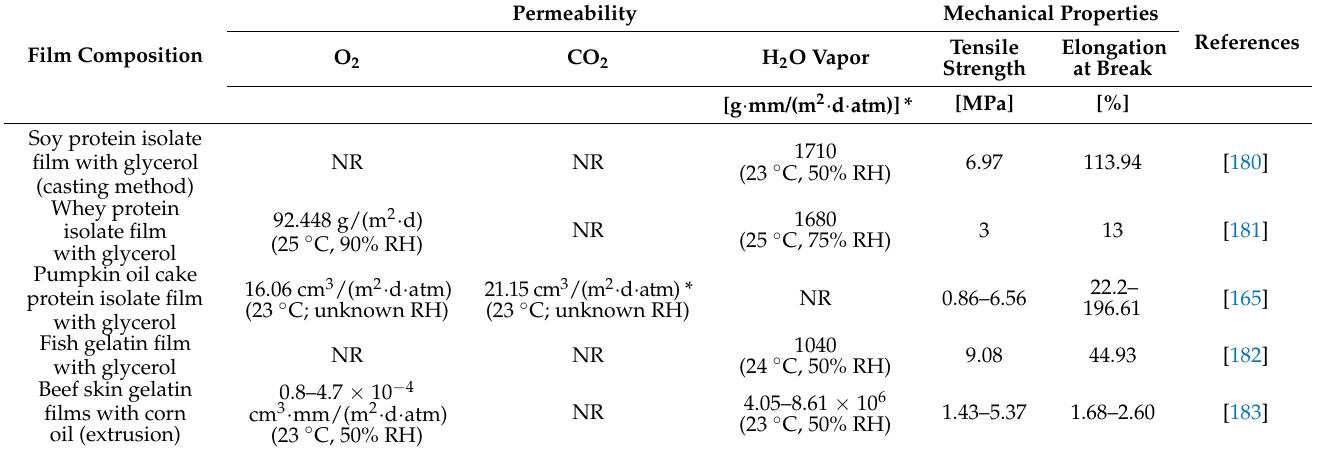
Table 3. Barrier and mechanical properties of protein-based